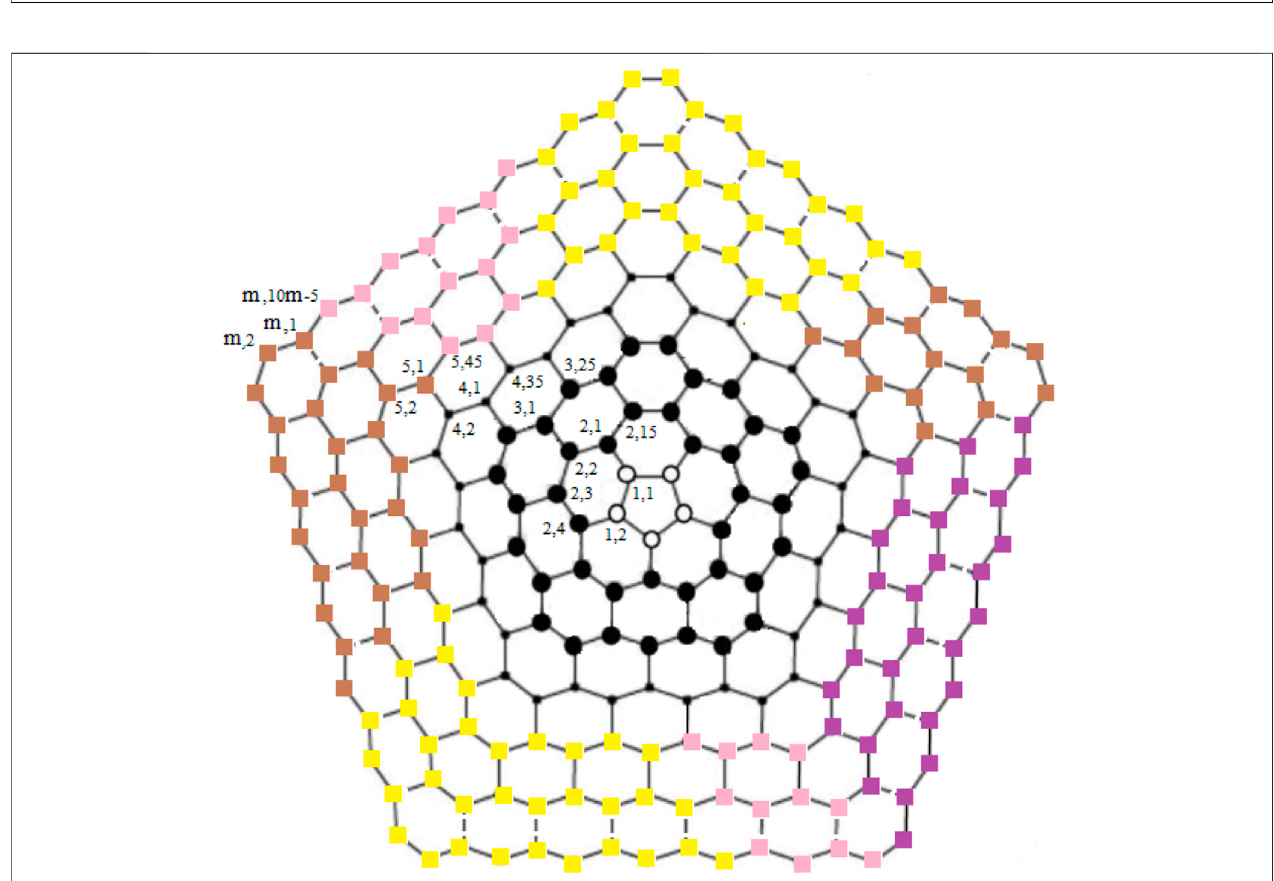
FIGURE 6 | CNC 5 [m] for Case 3 (Subcase